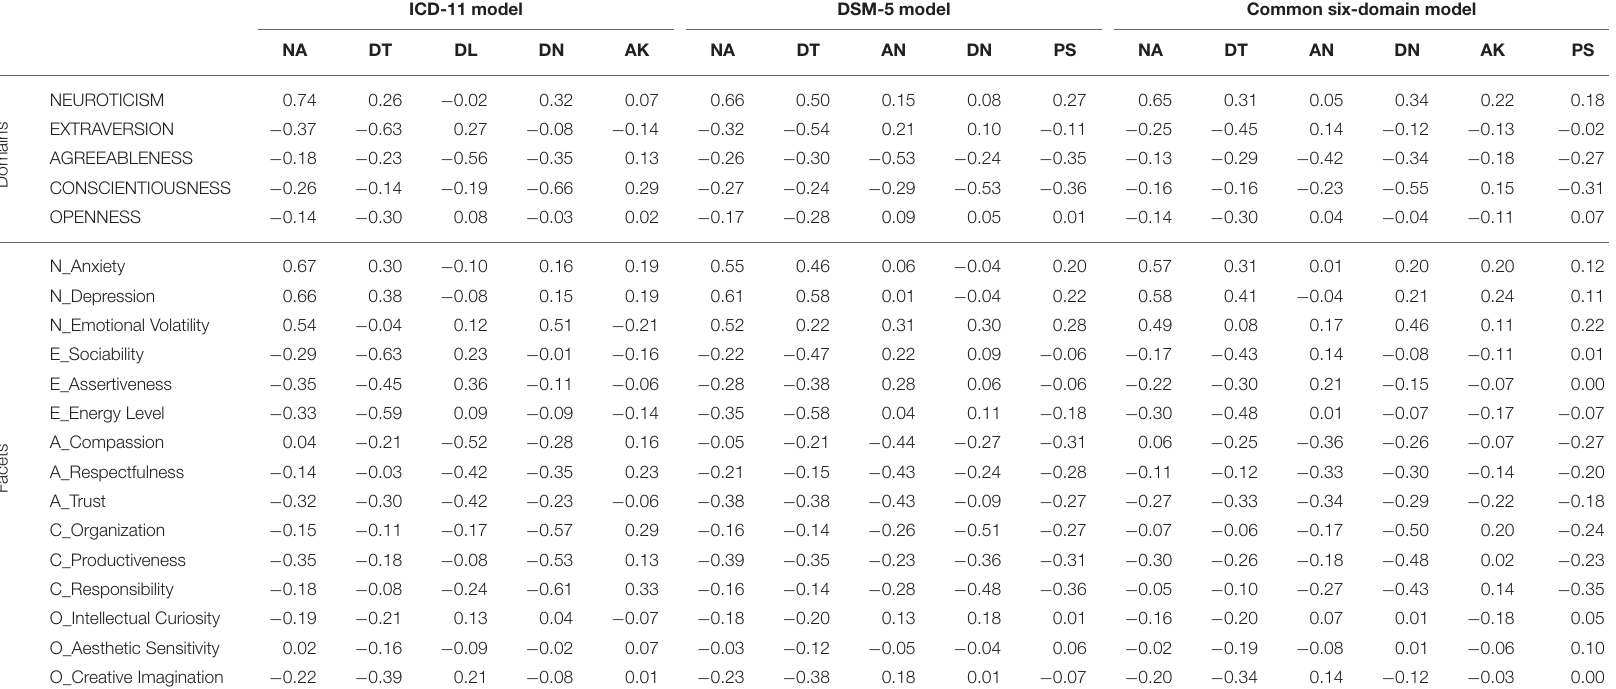
TABLE 2 | Correlations of FFM domains and facets with ICD-11 and DSM-5 domains in Study 1 ( N =